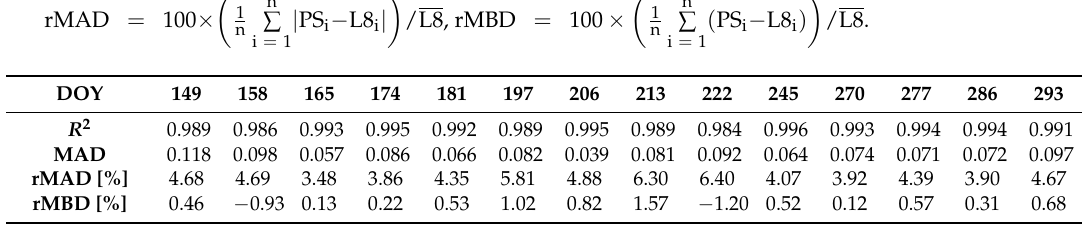
n ∑ − L8 | PS | , i i n i = 1